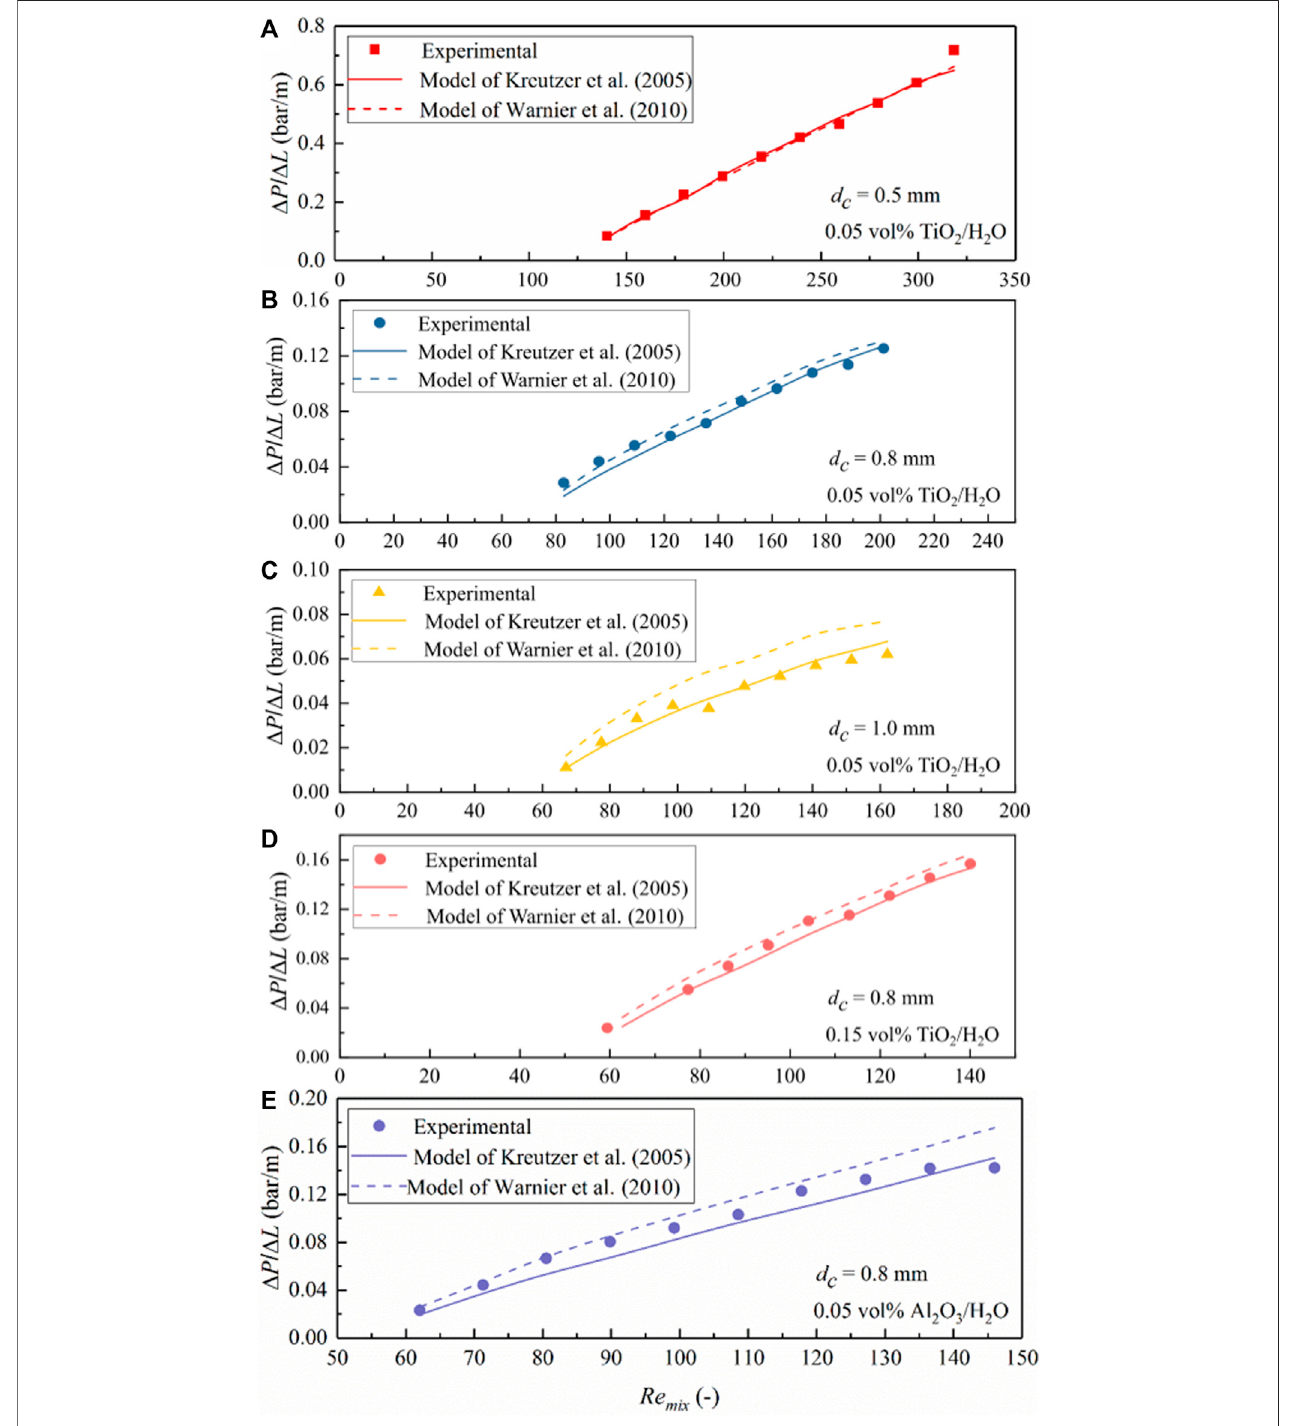
FIGURE 13 | Comparison of the measured pressure drop data for N 2 – TiO 2 /H 2 O and N 2 – Al 2 O 3 /H 2 O nano fl uid slug fl ows in the microchannel with predictions according to the models of Kreutzer et al. (2005) and Warnier et al. (2010). (A) TiO 2 /H 2 O, d c (cid:1) 0.5 mm, φ (cid:1) 0.05 vol%; (B) TiO 2 /H 2 O, d c (cid:1) 0.8 mm, φ (cid:1) 0.05 vol%; (C) TiO 2 /H 2 O, d c (cid:1) 1.0 mm, φ (cid:1) 0.05 vol%; (D) TiO 2 /H 2 O, d c (cid:1) 0.8 mm, φ (cid:1) 0.15 vol%. (E) Al 2 O 3 /H 2 O, d c (cid:1) 0.8 mm, φ (cid:1) 0.05 vol%. Values of Re mix shown are evaluated based on the mixture velocity corresponding to the average pressure in the microchannel (the same for Figures 14 , 15 ).